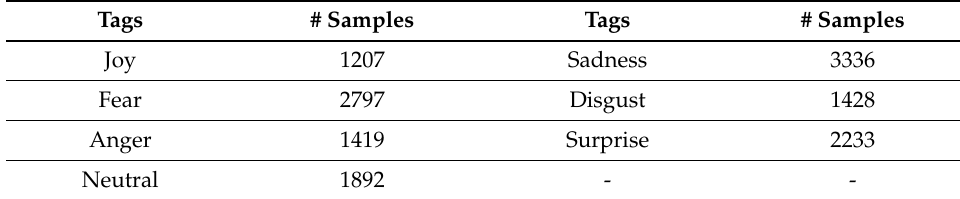
Table 4. Statistics of the dataset for task 2.